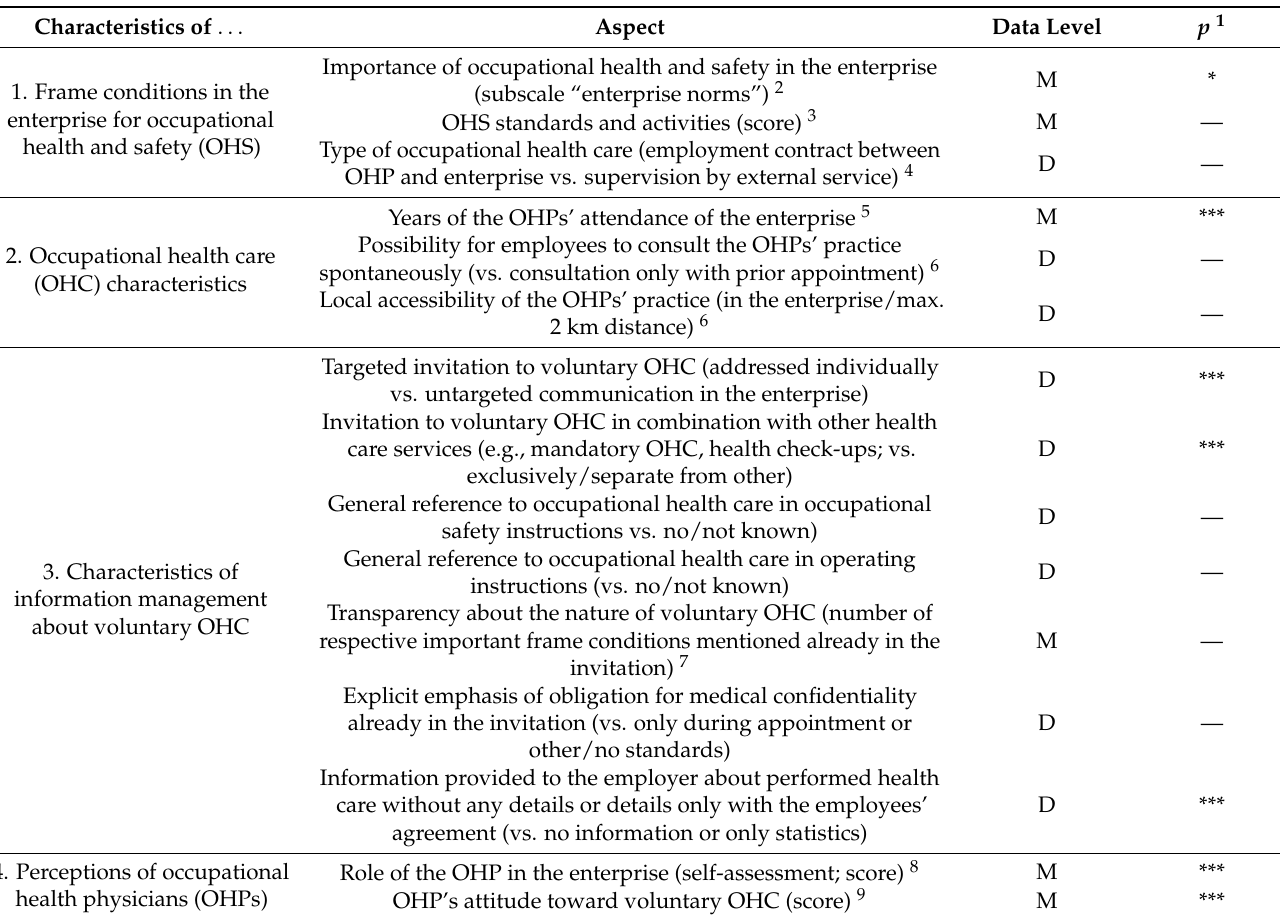
Table A3. Possible predictors tested exploratively on outcome “uptake of voluntary occupational health care” in bivariate logistic regression